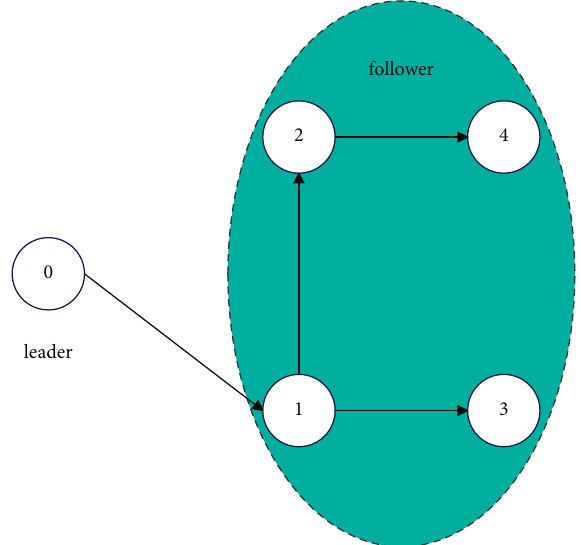
Figure 3: Interactive network topology of the multiagent